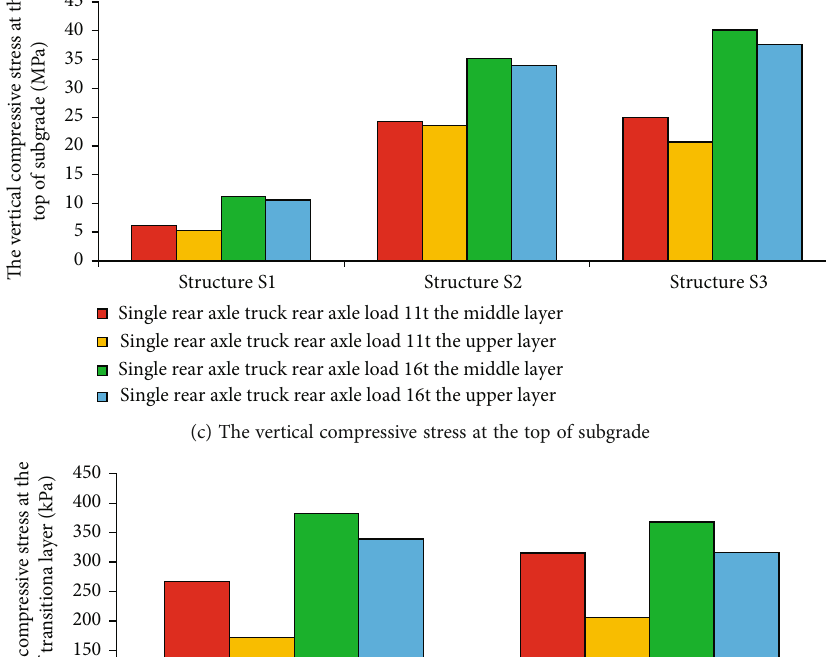
Single rear axle truck rear axle load 11t the middle layer